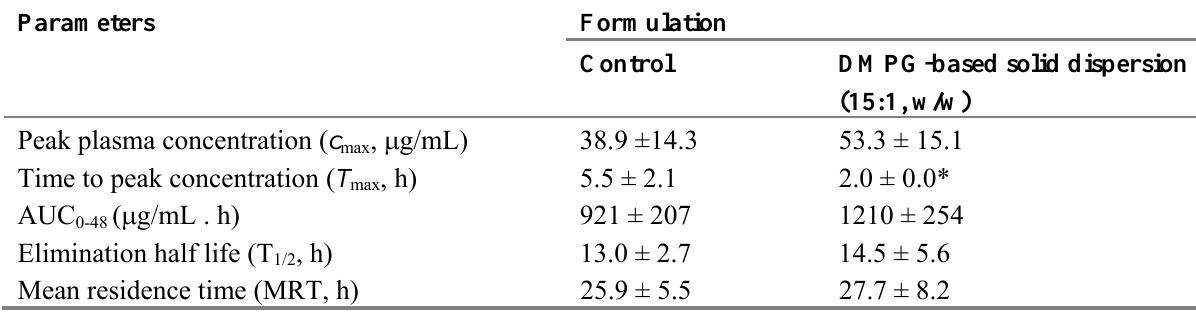
Table 3. Pharmacokinetic parameters (mean ± SD, n = 3) of two piroxicam formulations following single-dose oral administration in